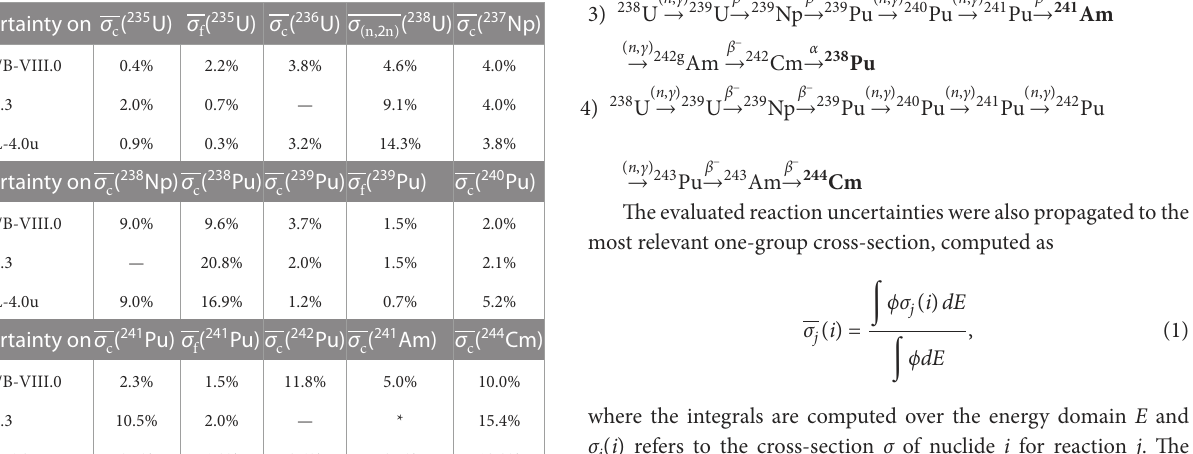
TABLE2 Uncertaintyofanumberofone-groupreactions.Forreadability, thereactionsarereportedinthecolumns(c:capture,f:fission(n,2n)(n,2n) reaction;—missingcovarianceevaluation,*:covariancematrixnot processed).Uncertaintiesrangingfrom1.0%—JEFF-3.3and ENDF/B-VIII.0—to1.2%—JENDL-4.0u—werefoundfortheone-group capturecross-sectionof 238